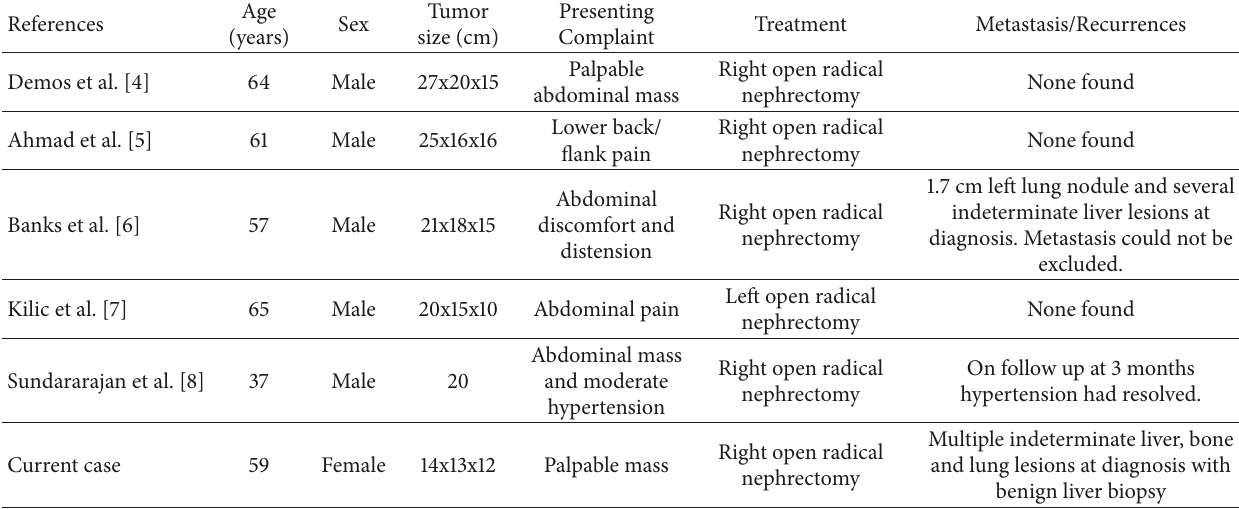
Table 1: Largest reported renal